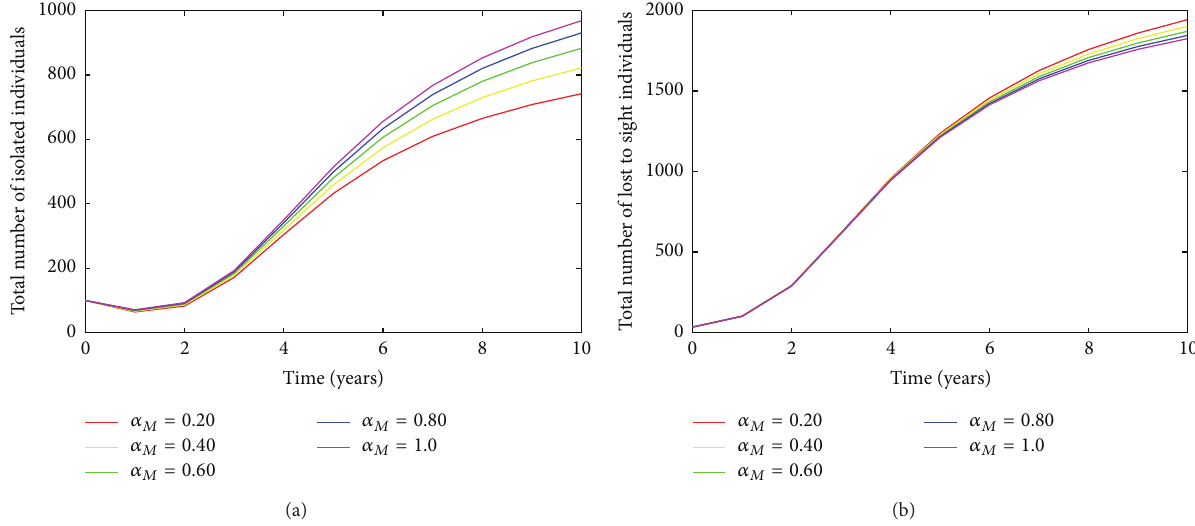
Figure 8: Simulation of model (2) as a function of time varying 𝛼 𝑀 for (a) total number of isolated individuals and (b) total number of individuals who are lost to follow-up. Parameter values used are as given in Table